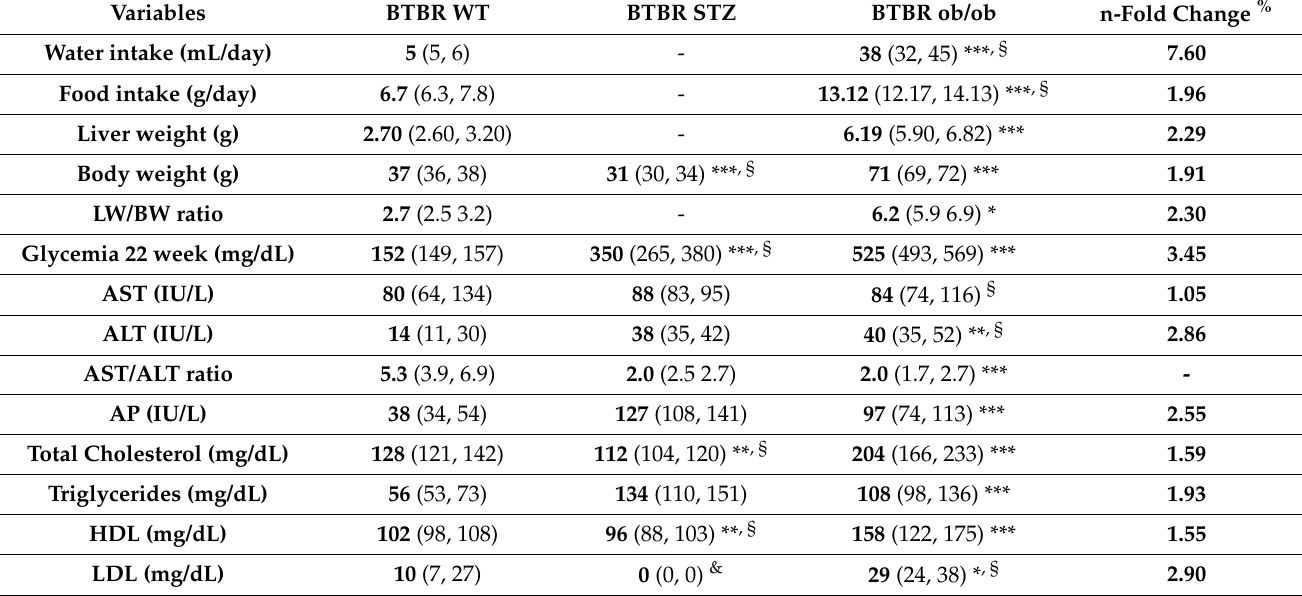
Table 2. Metabolic and biochemical parameters in BTBR WT, BTBR-STZ and BTBR